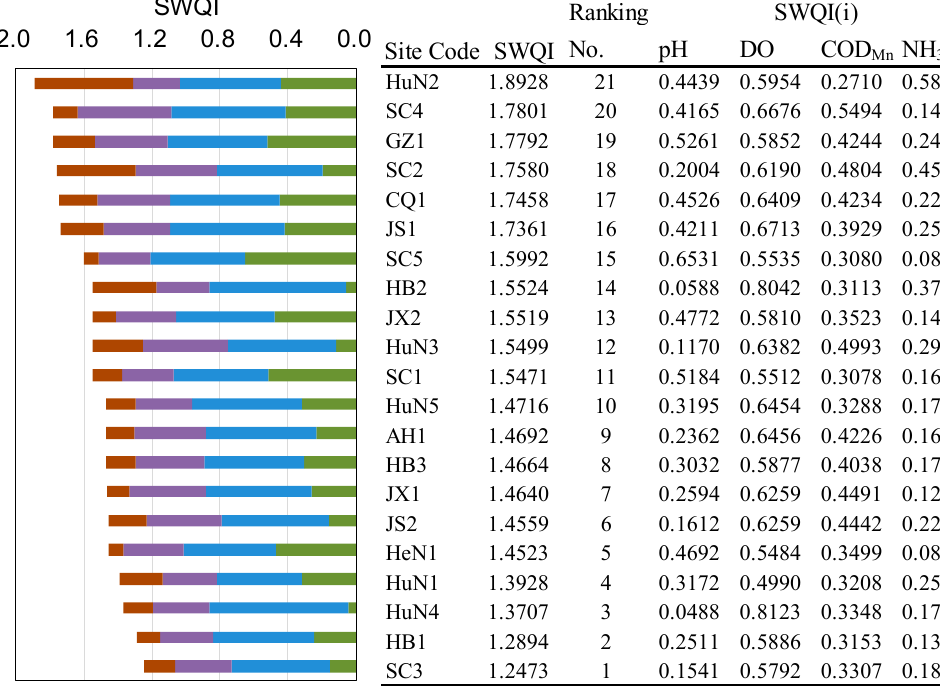
Figure 2. SWQIs and SWQI (i)s of the 21 YRB sites in 2016.